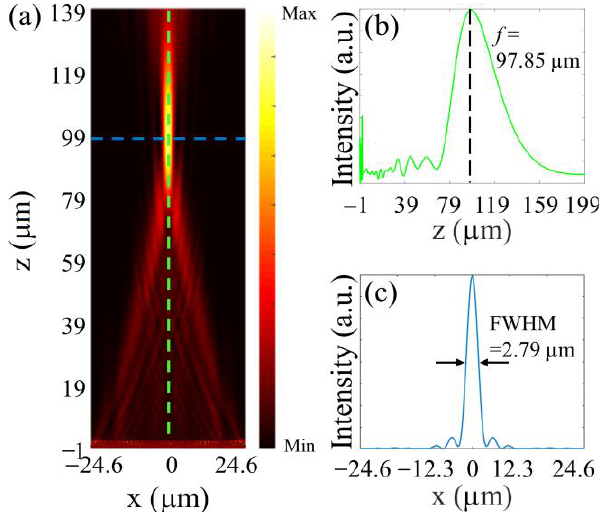
Figure 2. ( a ) Intensity profiles of the monolithic metalens along the propagation direction ( z -axis) in the x - z planes. The longitudinal and horizontal cuts of the focal behavior are marked with green and blue dashed lines, as shown in ( b , c ), respectively.